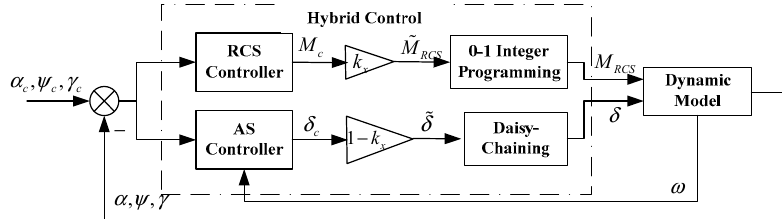
Figure 1. The structure diagram of the proportional allocation scheme.